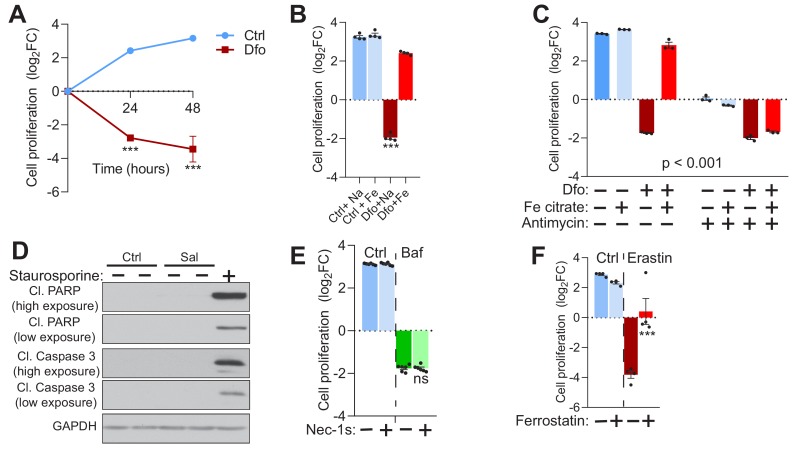
Iron deficiency-induced cell death is non-apoptotic.(A) 300 µM Dfo-treated fibroblasts show time dependent increase in cell death of up to about sixteen-fold after 48 hr of treatment. Data points are mean ± SEM, n = 4. ***p<0.001, unpaired t-test with Welch’s correction (B) 150 µM Iron citrate supplementation rescues cell death following 300 µM Dfo treatment in fibroblasts. Bar graphs and error bars represent mean ± SEM of log2 fold change in cell number of experimental conditions. Black dots indicate individual experimental measures. ***p<0.001, Welch’s one-way ANOVA with Dunnett’s correction for multiple comparisons. Mean differences compared between Dfo alone treatments and the other experimental groups. (C) 20 µM Antimycin treatment abrogates the rescue of cell death following iron supplementation in Dfo-treated fibroblasts. Results are summarized at mean ± SEM, n = 3 (depicted as black dots). ***p<0.001; Two-way ANOVA with Sidak correction of for multiple comparisons. (D) Caspase 3-independent cell death in 500 nM Sal-treated fibroblasts shown by whole cell immunoblots of cleaved PARP and cleaved caspase three levels in Sal-treated cells (n = 3). 1 µM Staurosporine treatment for 4 hr is used as positive for caspase 3-dependent cell death. GAPDH is used as loading control. (E) 5 µM Nec-1s, metabolically stable RIPK1 inhibitor, has no observable effects on cell death induced by 500 nM Baf treatment in fibroblasts for 48 hr. Results show mean ± SEM of 6 experimental replicates. ns p>0.05, Welch’s one-way ANOVA with Dunnett’s correction of multiple comparisons. Baf alone treated group compared with all other treatment conditions. (F) 5 µM Ferrostatin treatment abrogates 10 µM Erastin-induced cell death in fibroblasts. Treatments were carried out for 48 hr. Bar graphs represent mean ± SEM, n = 4 (black dots). ***p<0.001, Welch’s one-way ANOVA with Dunnett’s correction for multiple comparisons (all groups compared to cells treated with erastin alone).